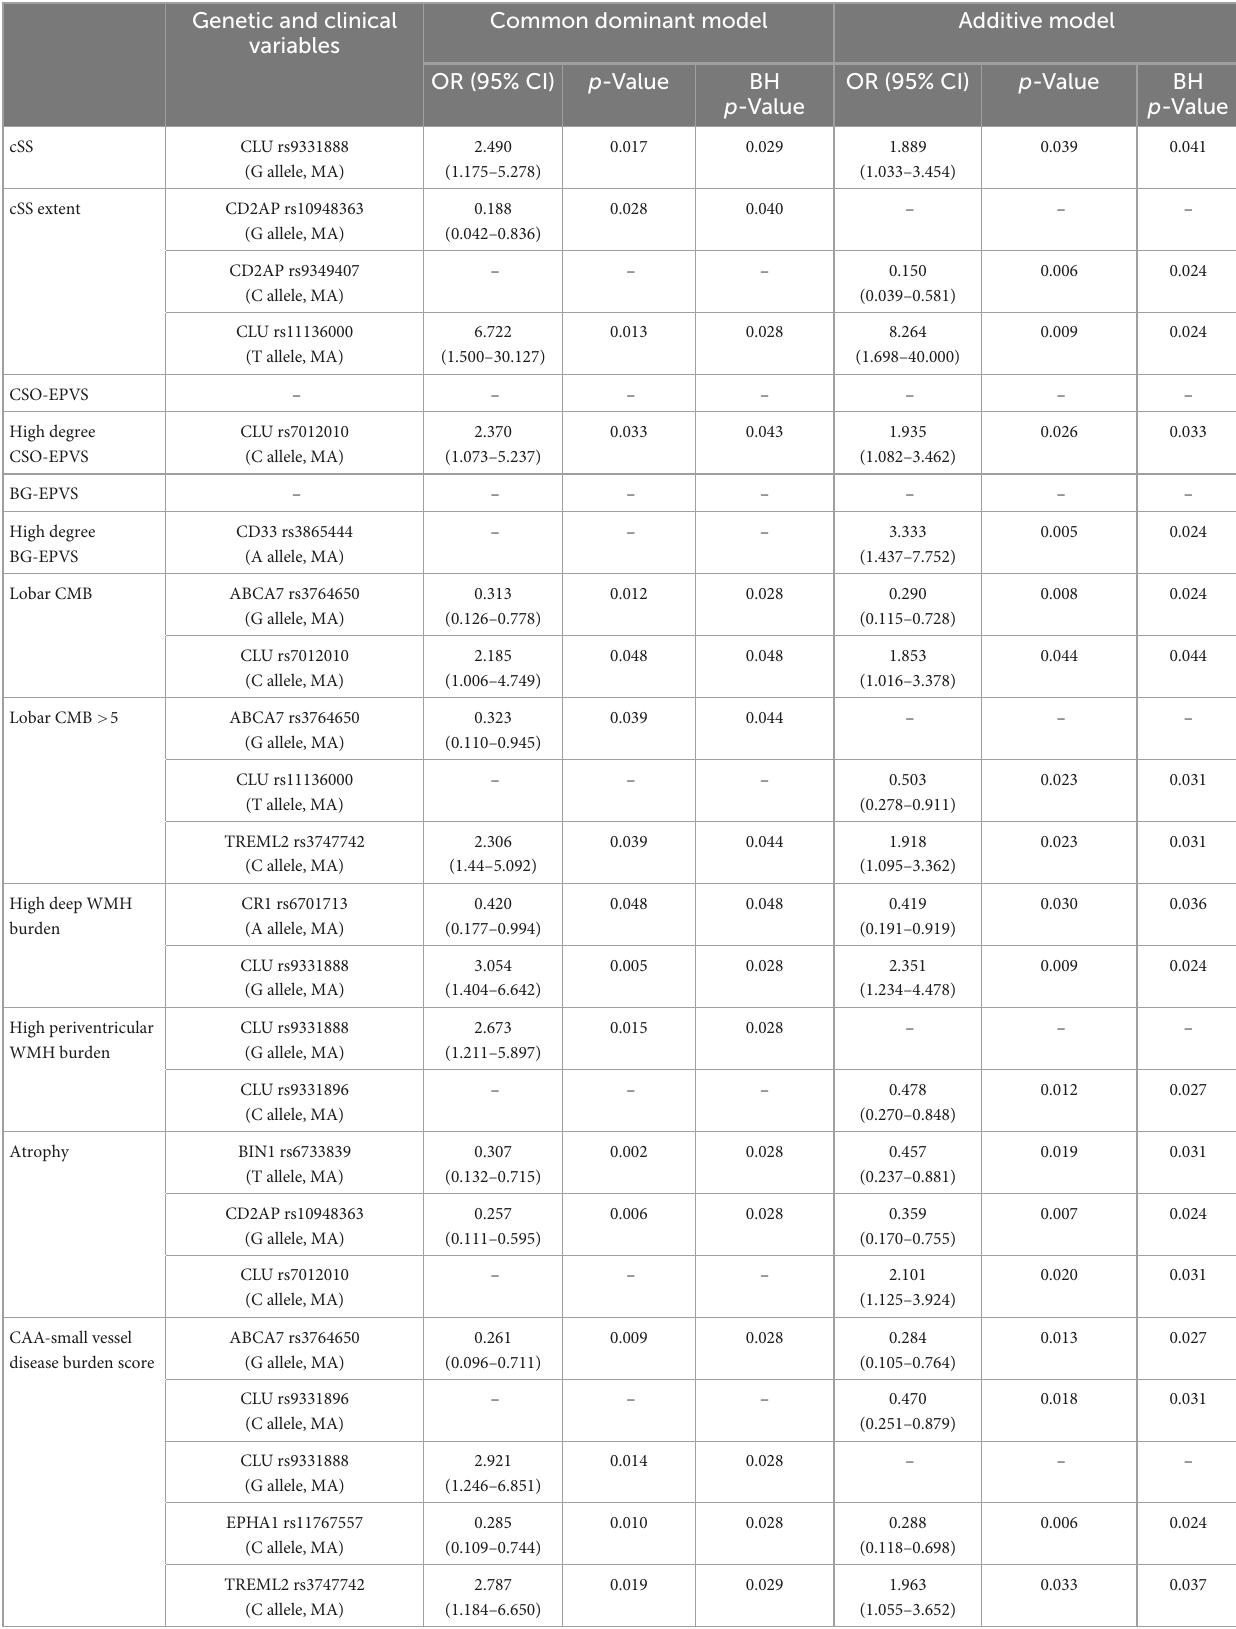
TABLE 3 Binary logistic regression for CAA MRI markers with SNPs minor alleles adjusting by sex and age. Genetic and clinical